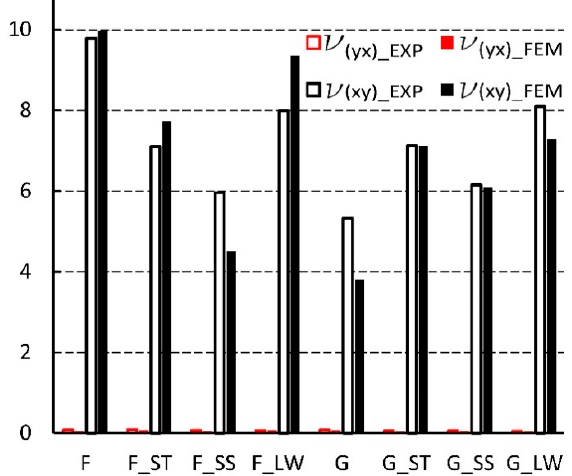
Figure 14. Poisson’s ratio for cells of the type: F, G (EXP-experimental research, FEM-numerical calculations).